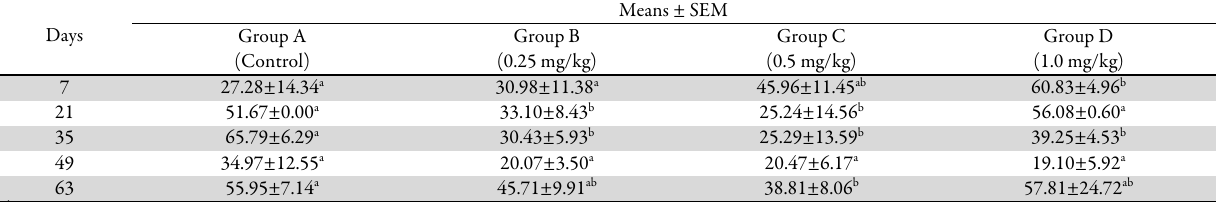
Table 2. Mean serum low density lipoprotein cholesterol concentration (mg/dl) of albino rats given graded doses of whole quail egg per kilogram body weight (± SEM) Days